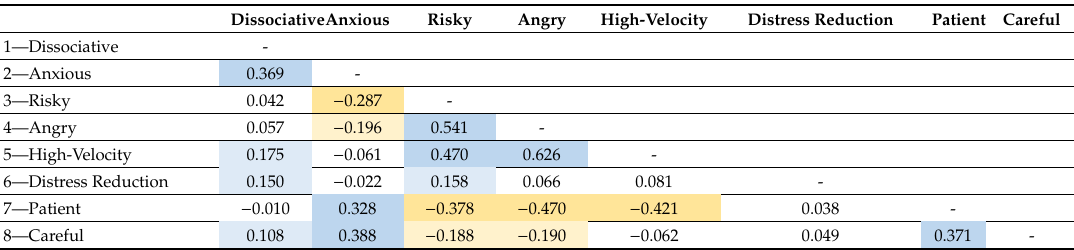
Table 6. Correlation (R) among driving styles. The background indicates the level of correlation between the variables: blue is positive, ochre is negative. Color saturation indicates the magnitude of the correlation.